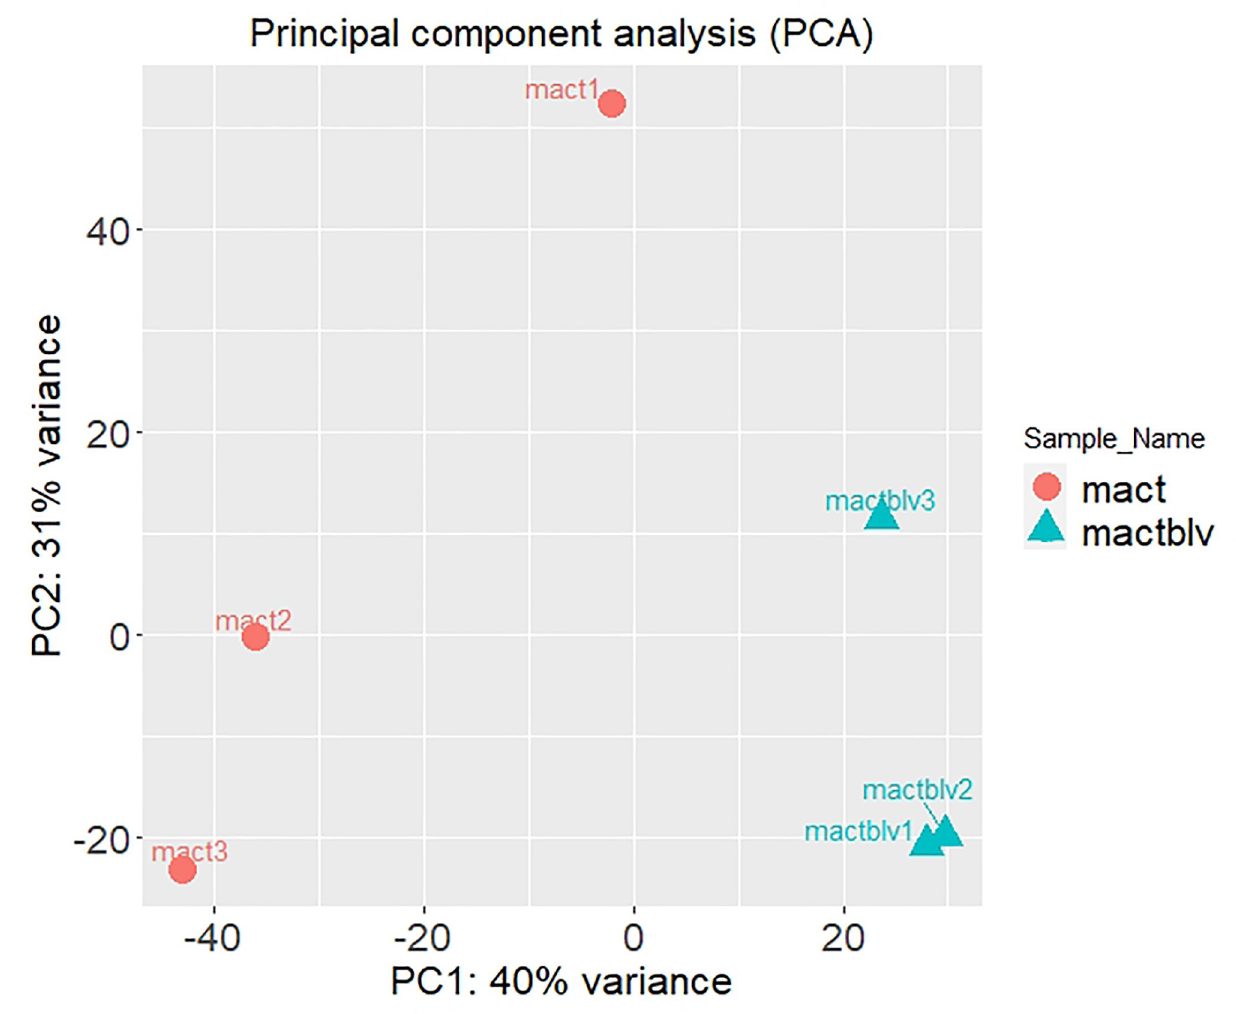
Fig 2. PCA from MAC-T and MAC-T BLV samples. Scatter plots of the first two principal components of the normalized gene expression profiles of MAC-T and MAC-T BLV. The PCA plot shows the variance of the three biological replicates of MAC-T and MAC-T BLV. Each axis represents the percentages of variation explained by the principal